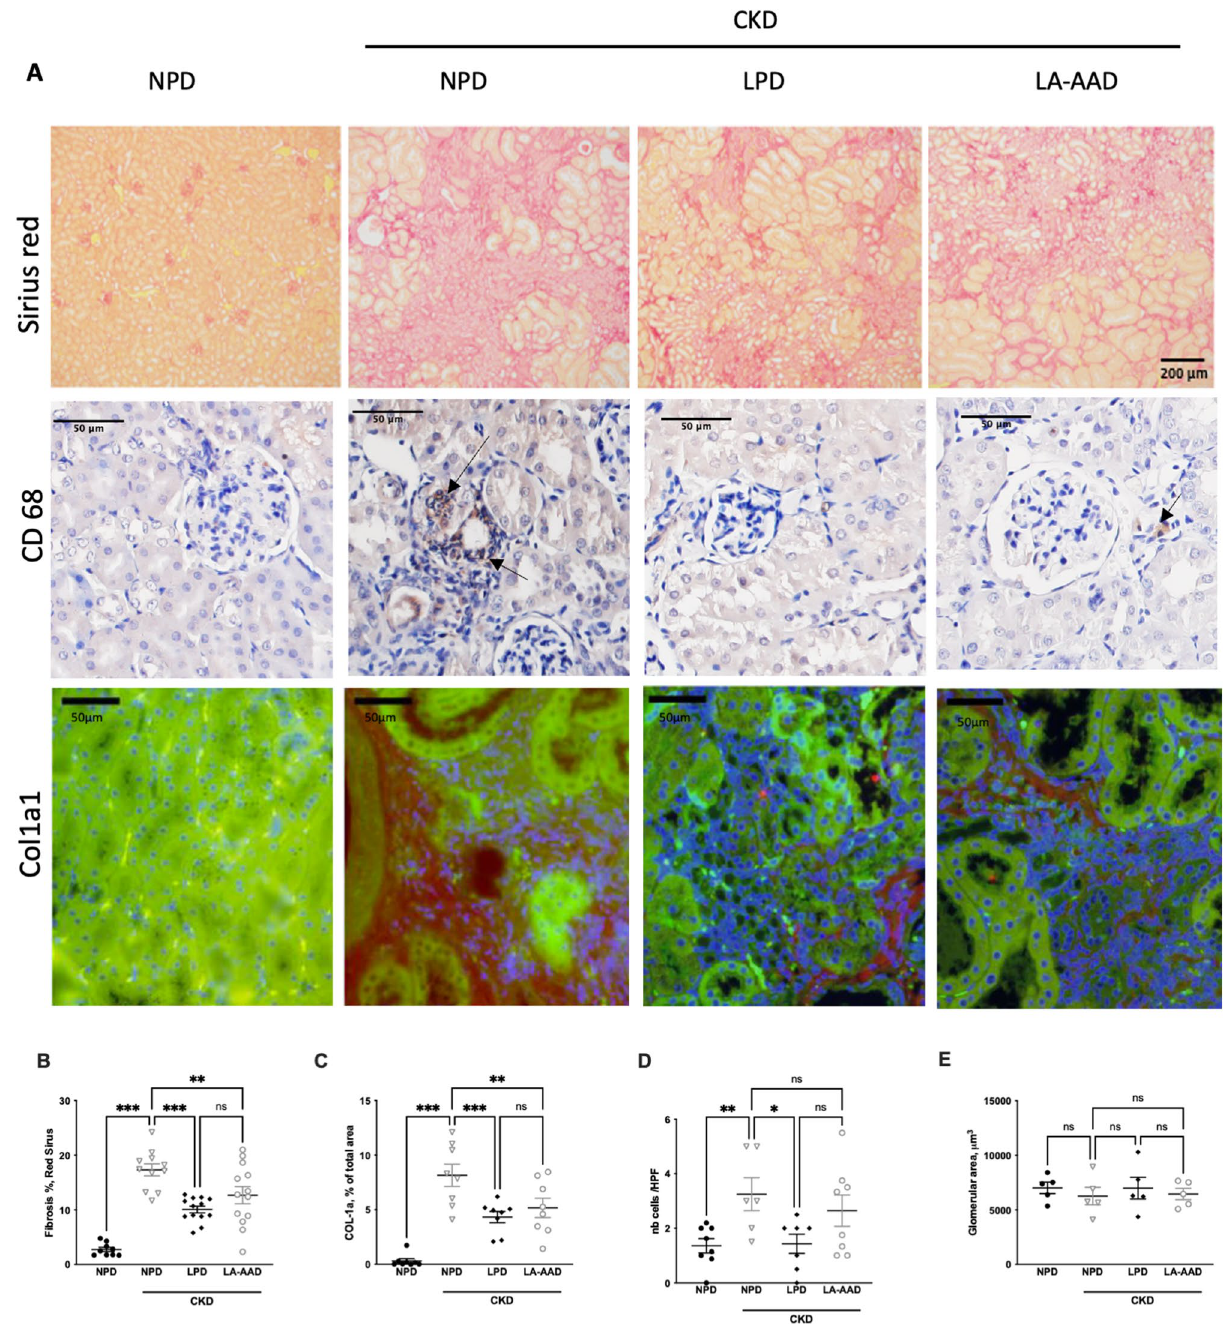
Figure 3. Evaluation of kidney fibrosis, glomerulosclerosis and kidney inflammation in control and CKD mice. ( A ) Representative images of kidney sections stained with Sirius Red viewed under bright field × 10. Scale bar represents 200 µm. Immunohistochemistry staining for CD68 and immunofluorescence staining for Col1a1. Scale bar represents 50 µm. ( B ) Sirius red morphometric and ( C ) Col1a1 evaluation in control and CKD mice treated with normoproteic diet (NPD), low protein diet (LPD) and low aromatic amino-acid diet (LA-AAD). ( D ) Tubular cell damage scores obtained by CD68 quantification (E) Glomerular area was quantified using ImageJ software and expressed as glomerular volume. CKD: chronic kidney disease. Data are expressed as mean ± SEM for n = 9–13 animals in each group. ** p < 0.01, *** p < 0.001 versus CKD-NPD; (ANOVA and Dunnett post hoc test). nb